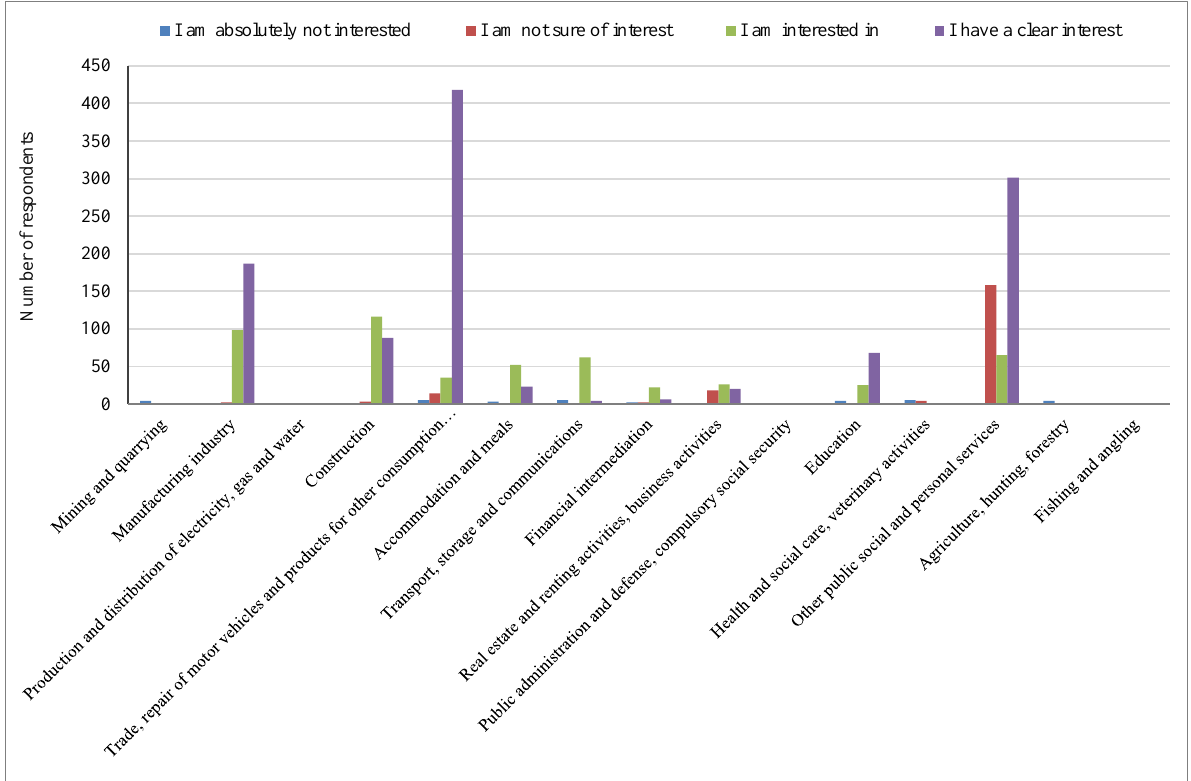
Figure 3. Graphic expression of the overall interest of the addressed respondents from the Olomouc agglomeration in the services of the Neuromarketing Center according to individual CZ-NACE and level of